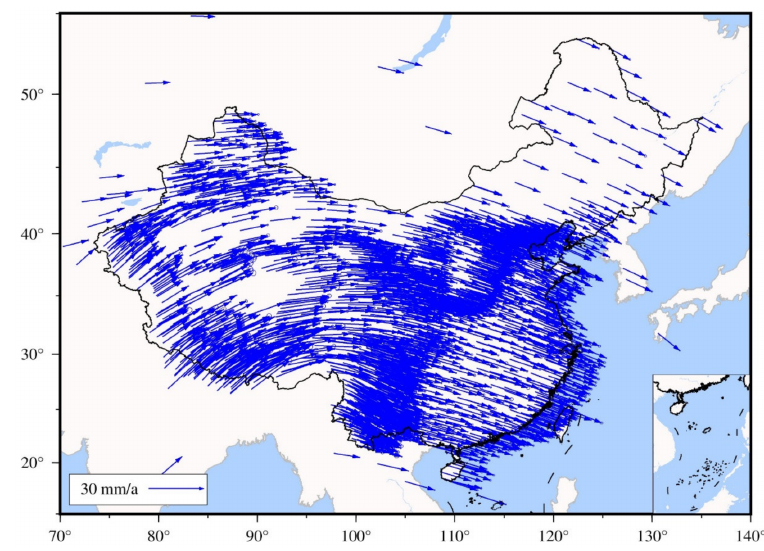
Figure 4. GNSS horizontal velocity field of ITRF2014 in continental China.